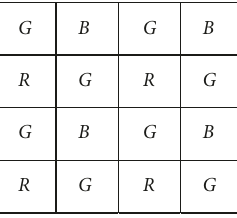
Figure 2: Bayer pattern color filter array